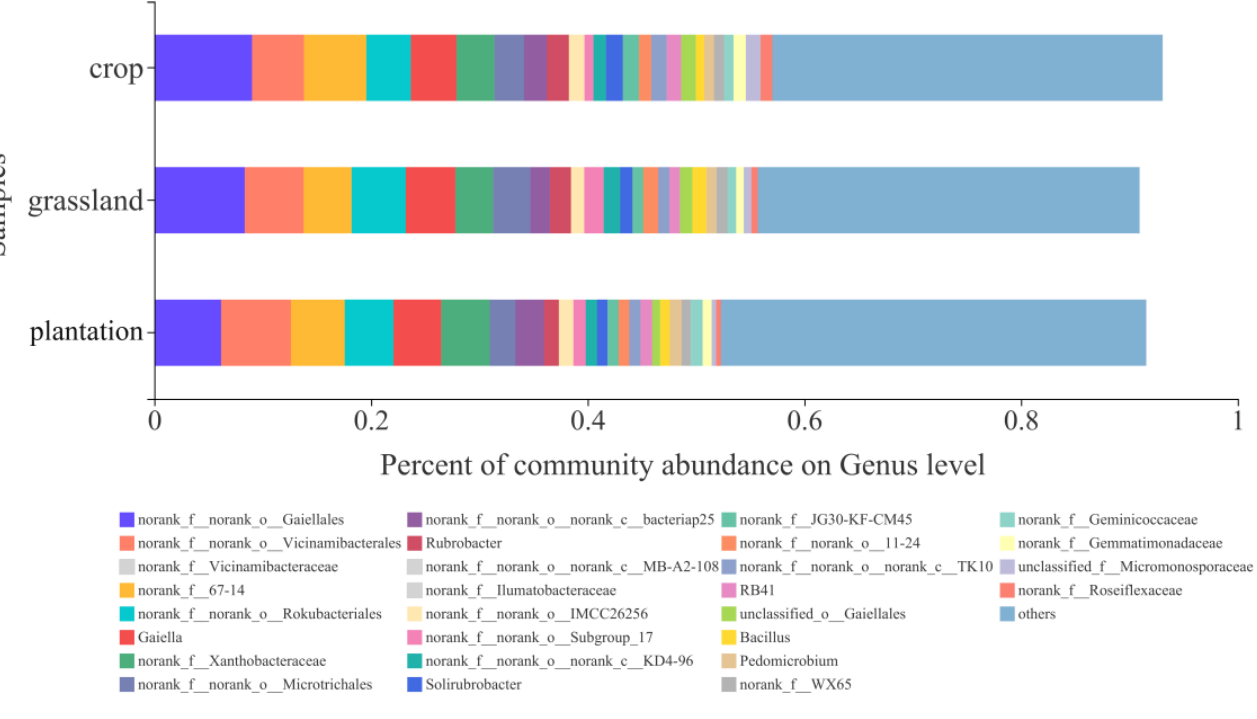
Figure 6. Heat maps and hierarchical clustering of the top 50 genera of soil bacterial community abundance in three karst land-use types.